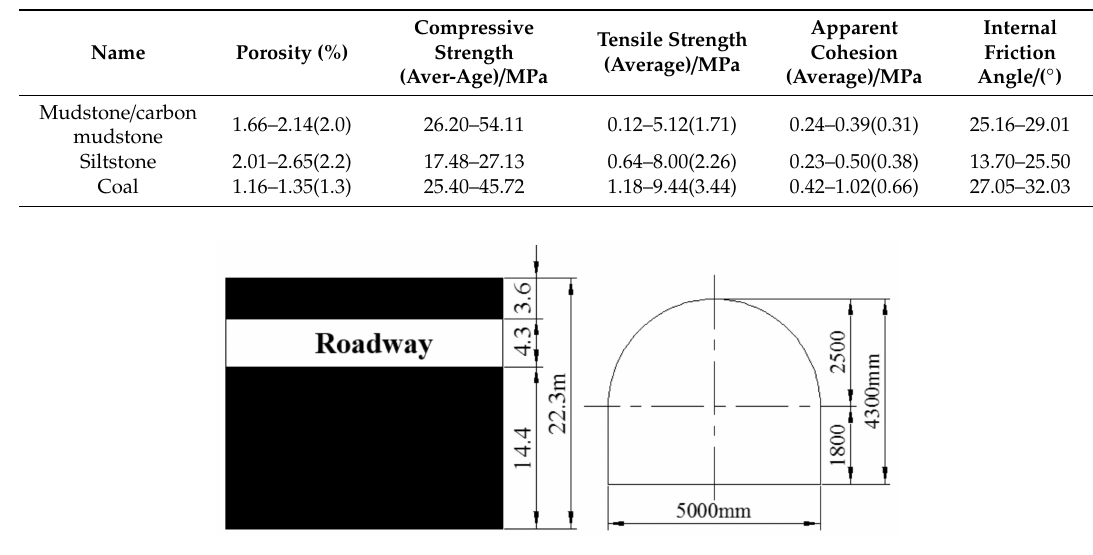
Figure 1. Relative position and section of the roadway.